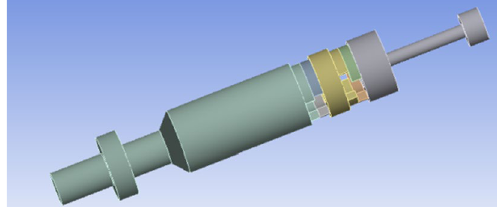
Figure 9. 3D model of the flow channel of oscillator.